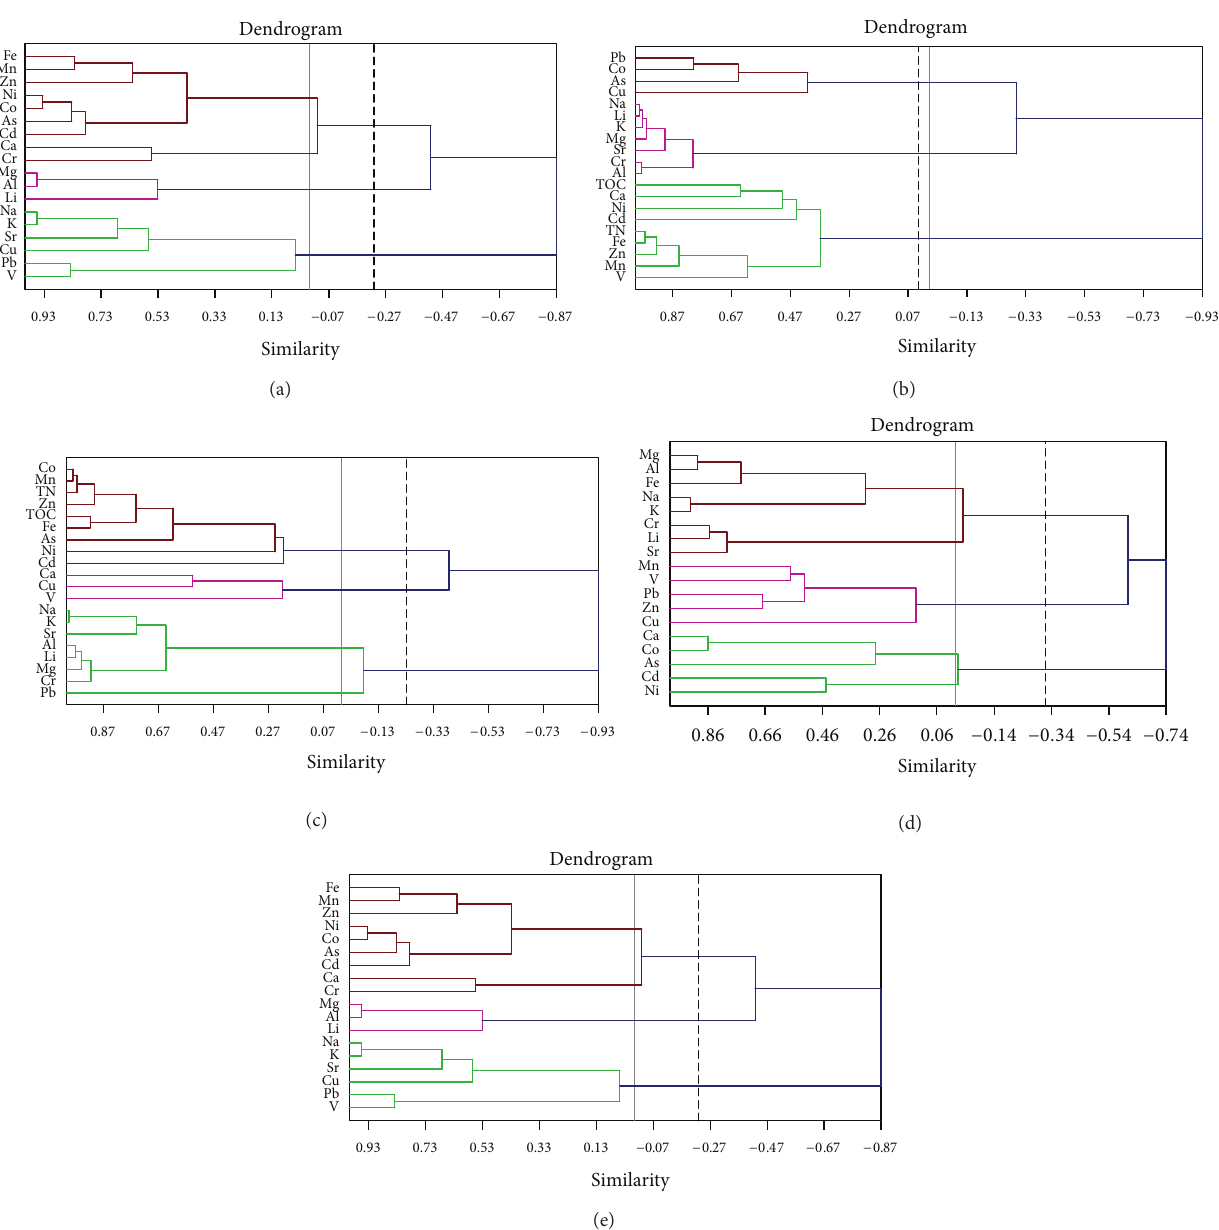
Figure 4: Metallic elements clustering results in the different parts of Bera